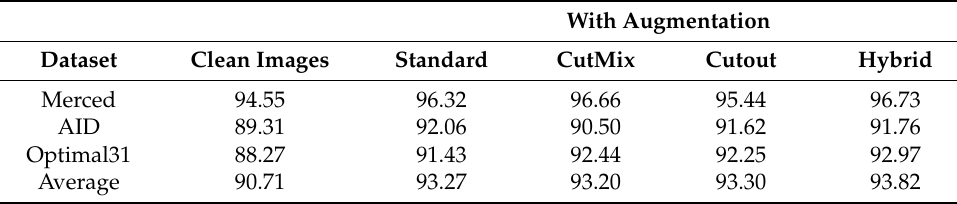
Table 3. Classification results on: (A): Merced dataset (30% train set), AID (10% trainset) and Optimal 31 (50% Train set). Image size: 224 ×